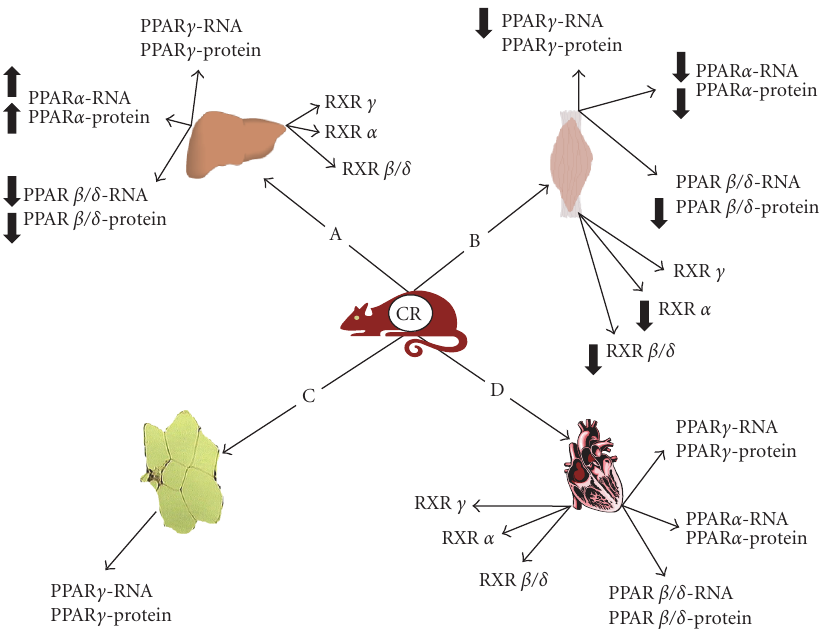
Figure 1: E ff ects of calorie restriction (CR) on the expression of PPARs family genes in mouse: (A) liver, (B) skeletal muscles, (C) white adipose tissue, and (D) heart. Arrows pointing up or down indicate statistically significant increases or decreases ( P < . 05). Lack of arrows means no